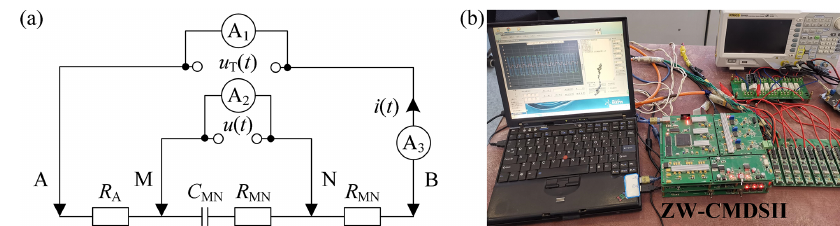
Figure 5. (a) Experimental schematic; (b) experimental setup.